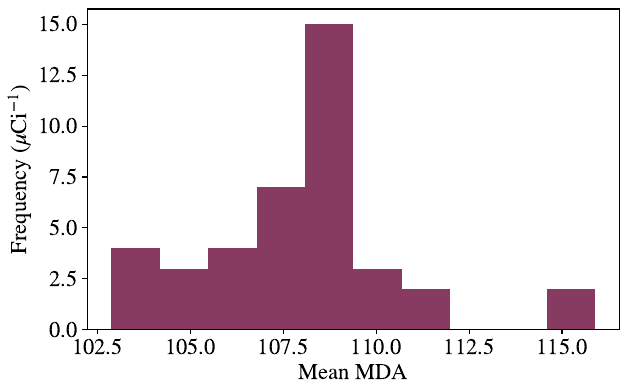
Figure 5. Histogram of mean MDA for autoencoders evaluated on the validation set. Each model, 40 models in total, was trained using a random value of the L2 regularization coefficient λ , and random configuration of number of neurons in the dense layers of the network. This figure shows that despite being trained with different parameters, initial weights, and mini-batches, most were able to yield similar performance. The model corresponding to the lowest mean MDA from this figure is examined further on the test